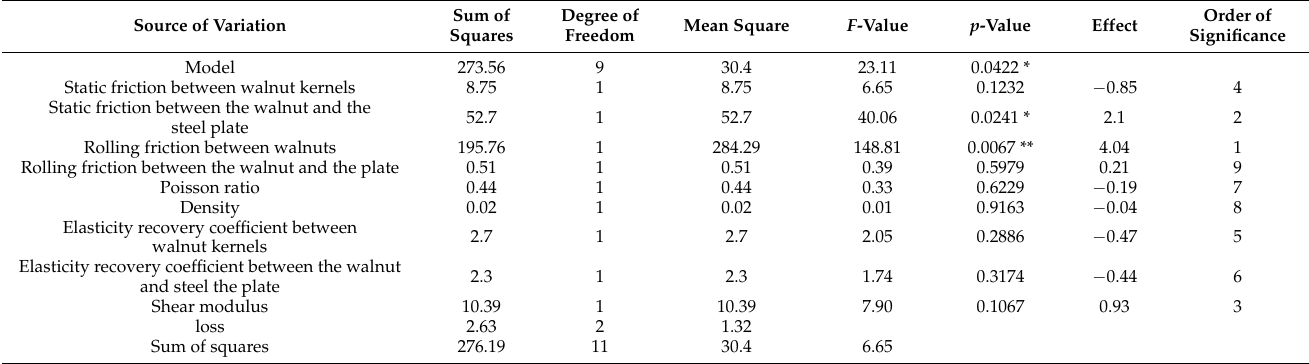
Table 5. The variance and effect of each parameter.